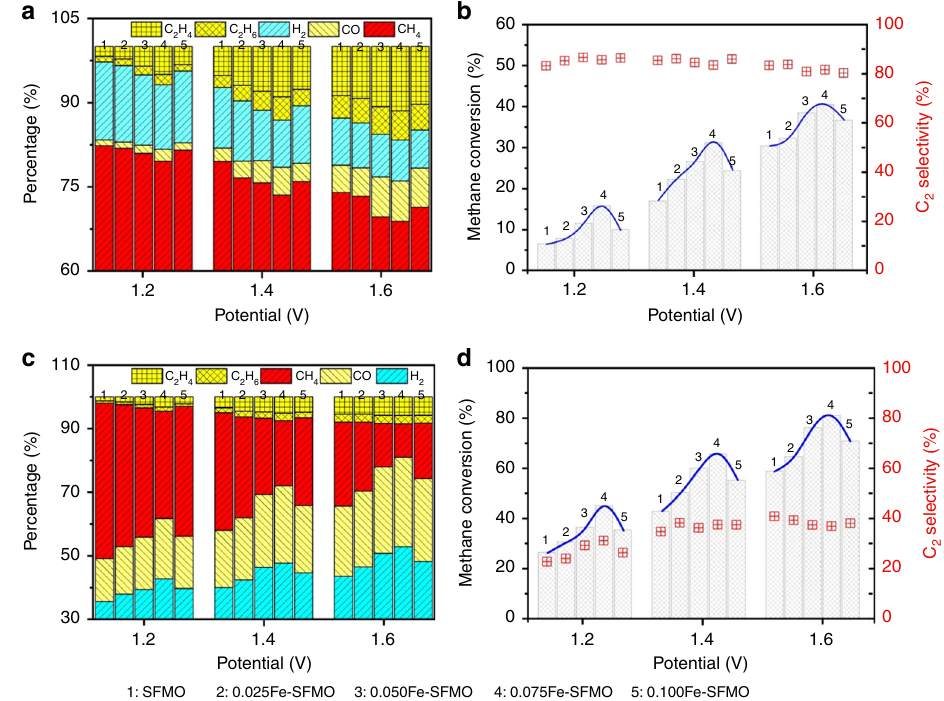
Fig. 4 CH 4 conversion and C 2 selectivity in conjunction with O 2 electrolysis. a The product analysis of electrochemical oxidation of CH 4 with different anodes. b C 2 selectivity and CH 4 conversion. c The product analysis of electrochemical CH 4 oxidation with composite anodes. d CH 4 conversion and C 2 selectivity after cycling the output